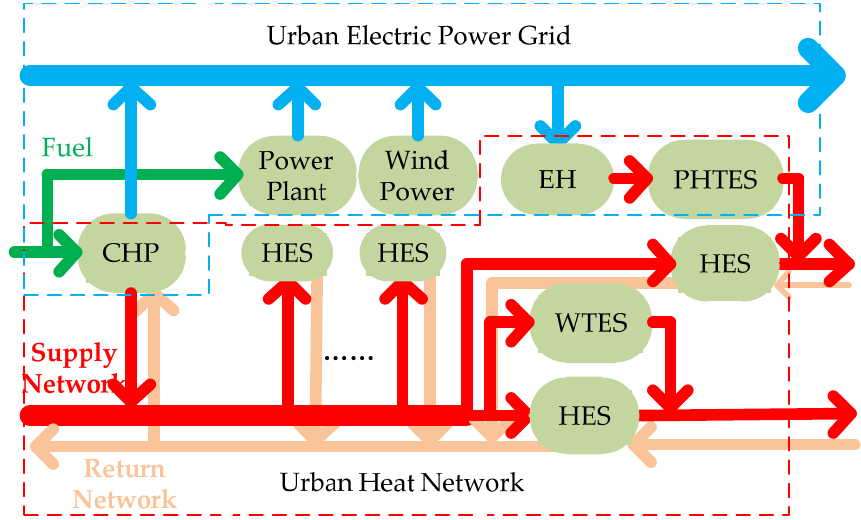
Figure 3. Structure diagram of a typical UEHIES.